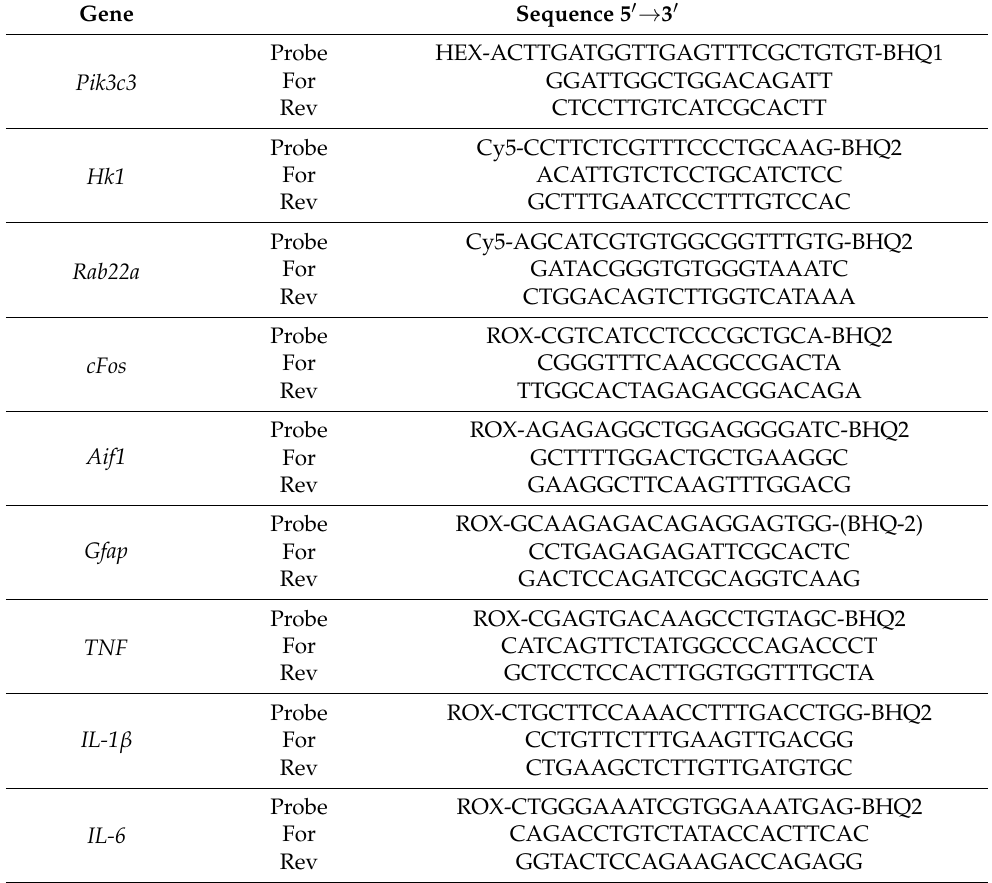
Table 2. The list of primers for